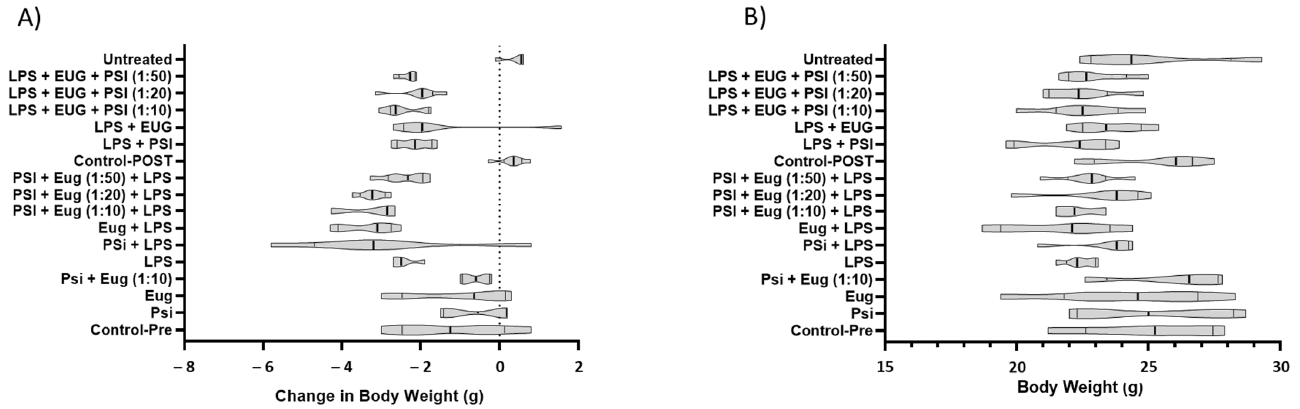
Figure 3. The effect of treatments on body weight ( A ) and body weight change ( B ) in the mouse model. Truncated violin plots. ANOVA and Tukey ( n = 4–6). Significance of differences for ( A ) can be seen in Table S3.